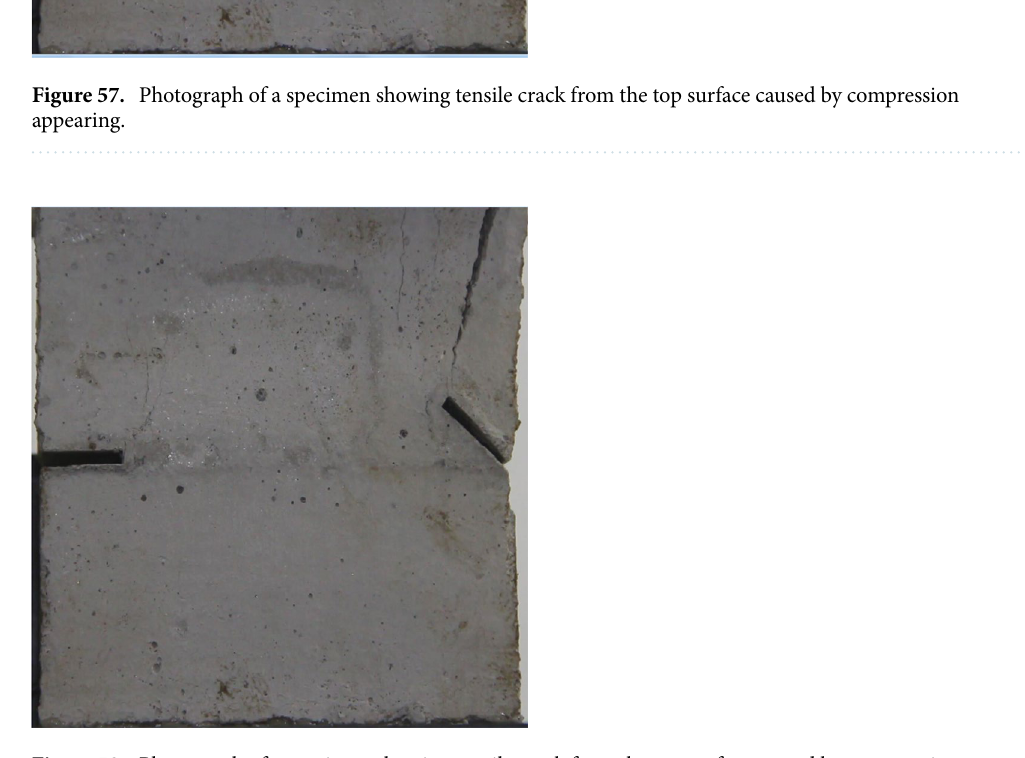
Figure 58. Photograph of a specimen showing tensile crack from the top surface caused by compression